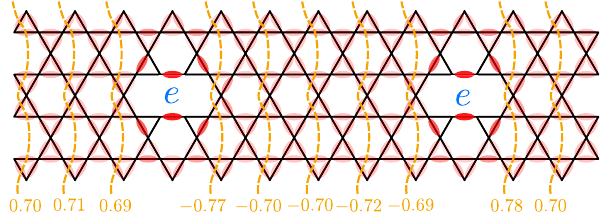
FIG. 13. A trapping potential for e anyons. The ground state (here, on a cylinder) for a lattice where four sites around a vertex are removed captures an e anyon. This result can be read off from the expectation value of the parity loops (dashed orange lines) around the circumference: If two neighboring loops have oppo- site sign, then a charge is enclosed.